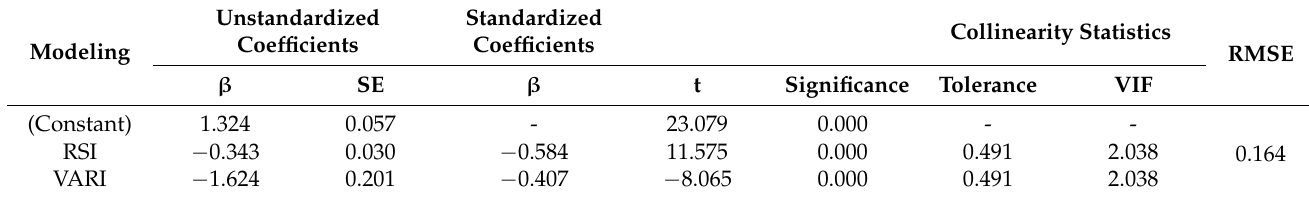
Table 7. Test results of the coefficients of the spectral index RSI and VARI